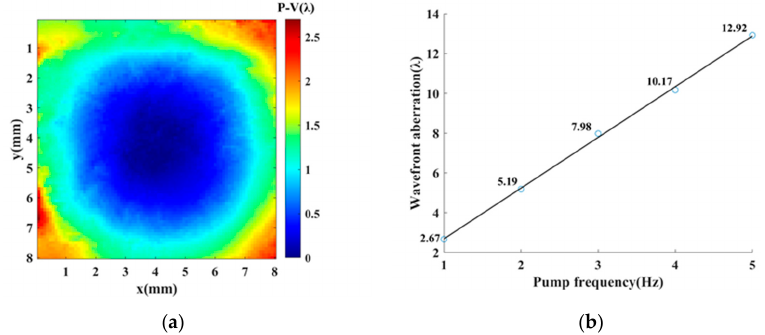
Figure 6. 2D Legendre polynomial coefficients for wavefront distortion with fixed O-rings at 1 Hz.